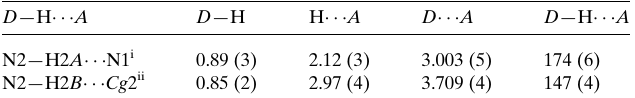
Table 2 Hydrogen-bond geometry (A˚ , (cid:2) ) for (II). Cg 2 is the centroid of the C4–C9 ring.